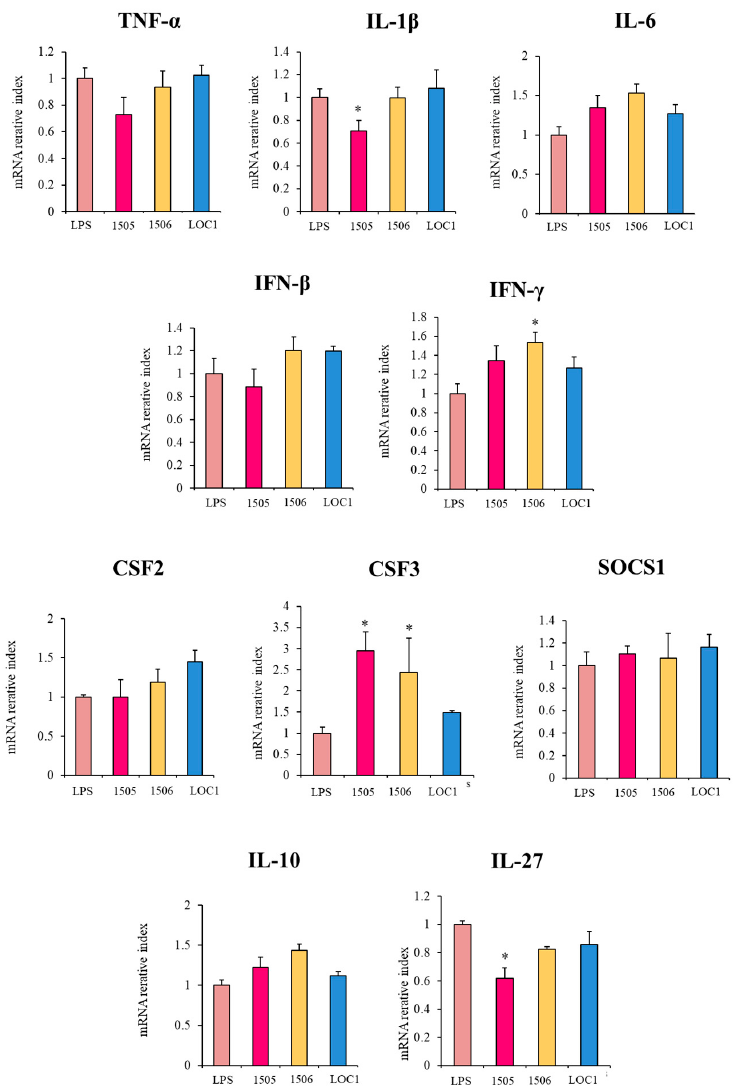
Figure 6. Effect of Lactiplantibacillus plantarum LOC1 in murine intestinal epithelial (MIE) cells and RAW macrophage co-cultures stimulated with the Toll-like receptor 4 (TLR4) agonist lipopolysaccharide (LPS). MIE cells in co-culture with macrophages were treated with L. plantarum LOC1 and then challenged with LPS. The expression of immune factors was determined in macrophages 3 h after LPS stimulation. Co-cultures treated with the probiotic strains Lacticaseibacillus rhamnosus CRL1505 or L. plantarum CRL1506 and then challenged with LPS were used for comparisons. Results represent data from three independents. Asterisks indicate significant differences between the indicated groups and LPS-challenged control co-cultures, (*) p <